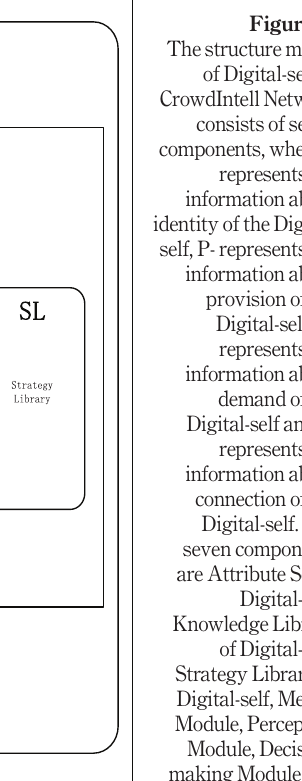
Figure 1. The structure model of Digital-self in CrowdIntell Network consists of seven components, where I- represents the information about identity of the Digital- self, P- represents the information about provision of the Digital-self, D- represents the information about demand of the Digital-self and C- represents the information about connection of the Digital-self. The seven components are Attribute Set of Digital-self, Knowledge Library of Digital-self, Strategy Library of Digital-self, Mental Module, Perception Module, Decision- making Module and Action